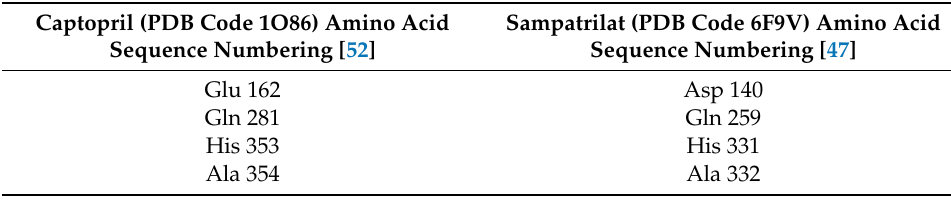
Table A1. Comparisons between Captopril (PDB code 1O86) and Sampatrilat (PDB code 6F9V) sequence